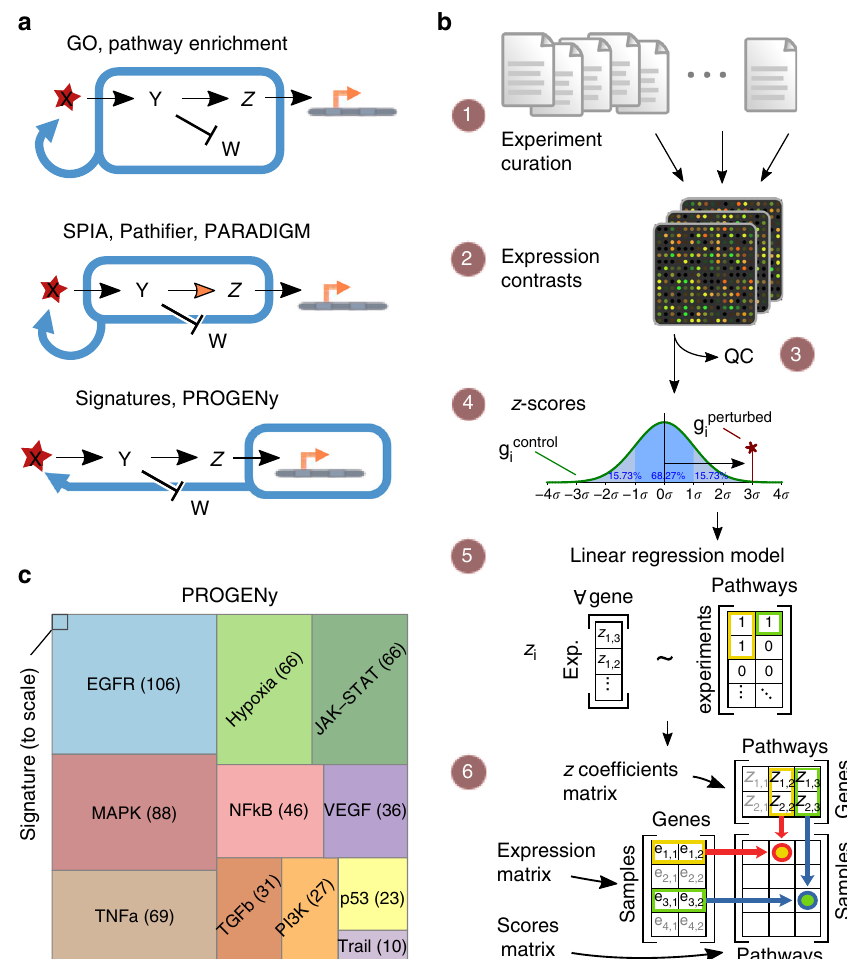
Fig. 1 Deriving pathway-response signatures for 11 pathways. a Reasoning about pathway activation. Most pathway approaches make use of either the set (top panel) or infer or incorporate structure (middle panel) of signaling molecules to make statements about a possible activation, while signature-based approaches such as PROGENy consider the genes affected by perturbing the pathway. b Work fl ow of the data curation and model building. (1) Finding and curation of 208 publicly available experiment series in the ArrayExpress database, (2) Extracting 556 perturbation experiments from series ’ raw data, (3) Performing QC metrics and discarding failures, (4) Computing z -scores per experiment, (5) Using a linear regression model to fi t genes responsive to all pathways simultaneously obtaining the z -coef fi cients matrix, (6) Assigning pathway scores using the coef fi cients matrix and basal expression data. See methods section for details. c Size of the data set compared to an individual gene expression signature experiment. The amount of experiments that comprise each pathway is shown to scale and indicated. Figure 1b (2) created by Guillaime Paumier is published under a CC-BY-SA license, sourced